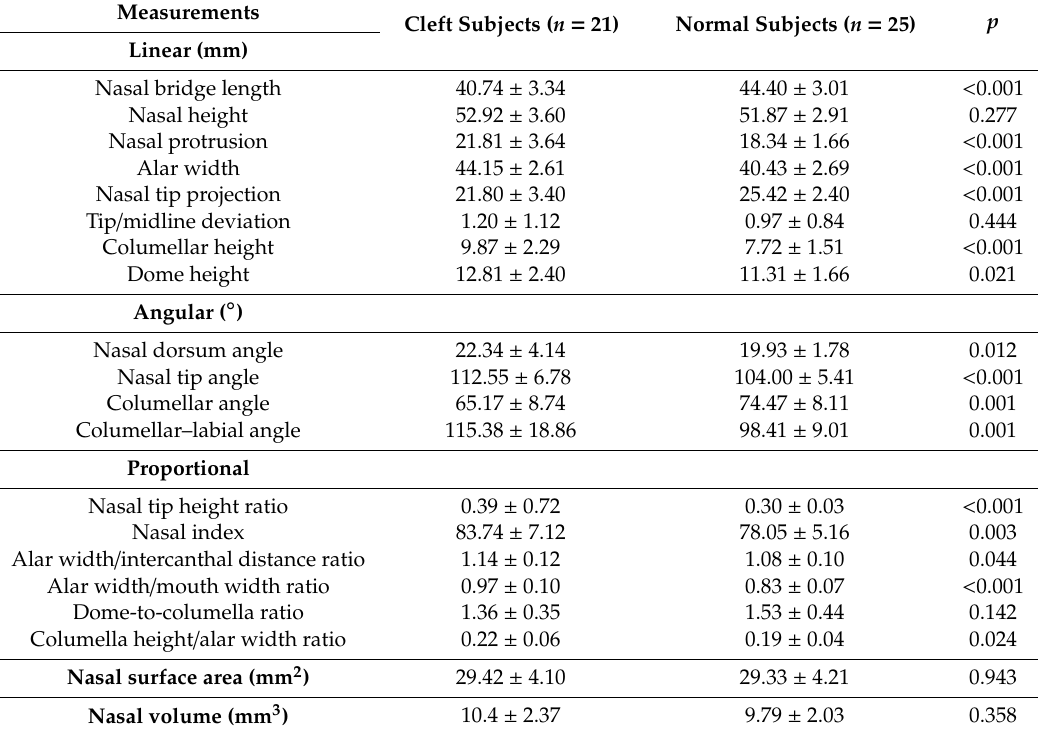
Table 5. Intergroup comparative analysis for male